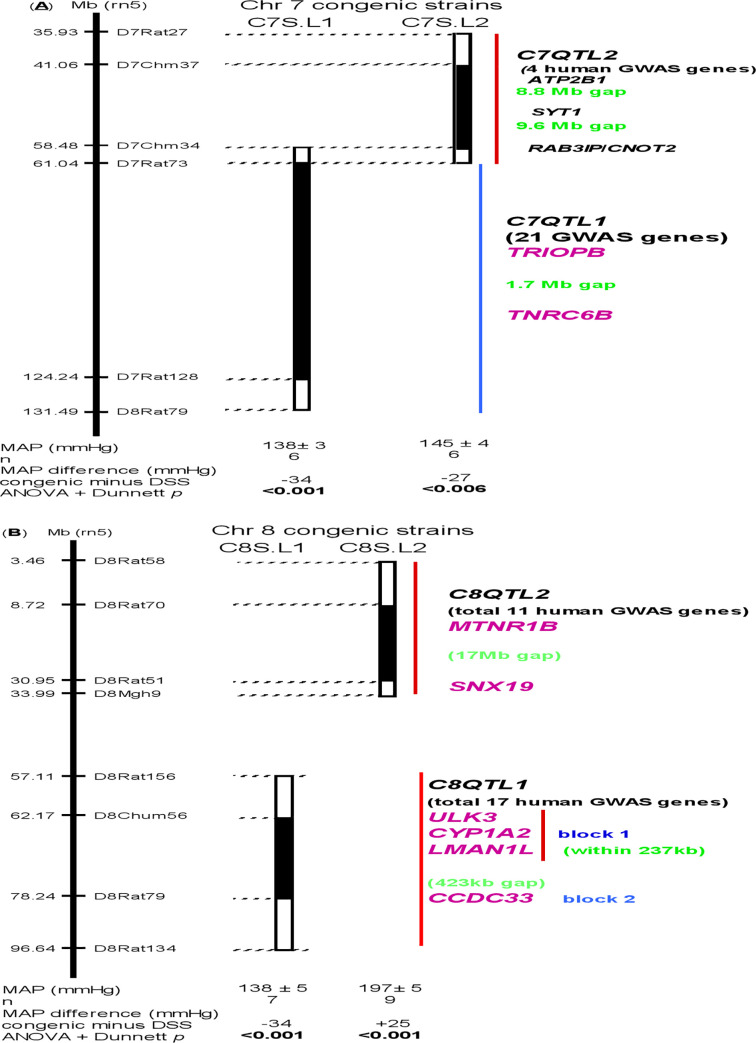
Congenic knock in genetics defining BP QTLs in vivo.A solid bar under congenic strains represents the Dahl salt-sensitive rat chromosome fragment that has been replaced by that of normotensive Lewis rats (S.L). Striped bars on ends of the solid bars denote the ambiguity of crossover breakpoints between markers [15]. Full names for abbreviated genes of interest are listed in the footnote for Table 1.